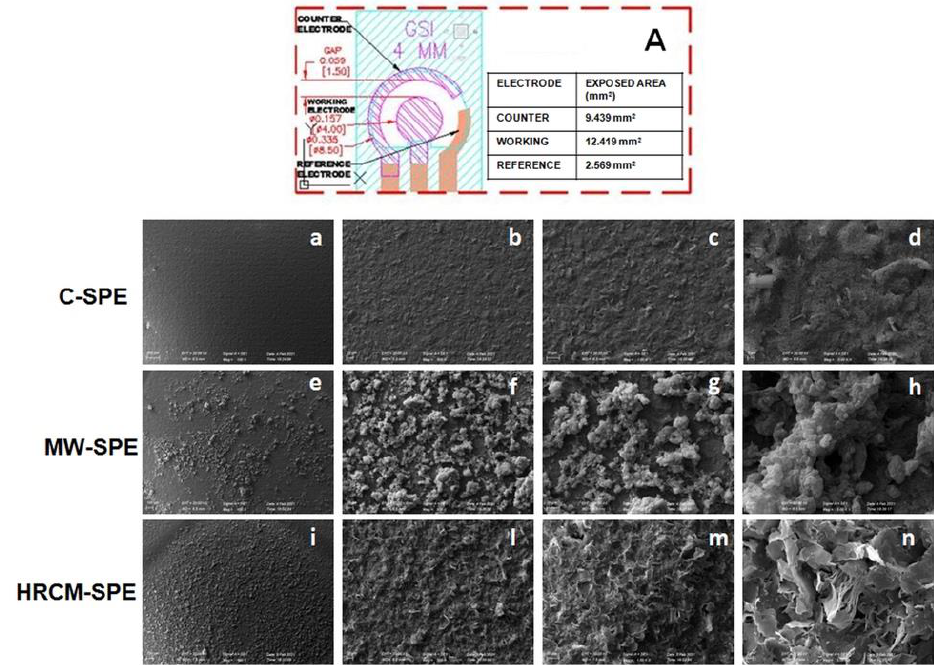
Figure 2. C-SPE schematic drawing ( A ) with details of working, counter, and reference electrode exposed areas. C-SPE ( a – d ), MW-SPE ( e – h ), and HRCM-SPE ( i – n ) environmental scanning electron microscope (ESEM) images of the WE surface at four different magnifications: ( a , e , i ) 100×, ( b , f , l ) 500×, ( c , g , m ) 1000×, and ( d , h , n ) 5000×. EHT = voltage acceleration (kV); WD = working distance, the distance between the sample surface and the final lens of the microscope; MAG = magnification, where X corresponds to the magnification (KX = X × 1000); SIGNAL A = SE1 indicates that the images were collected with the secondary electron detector.